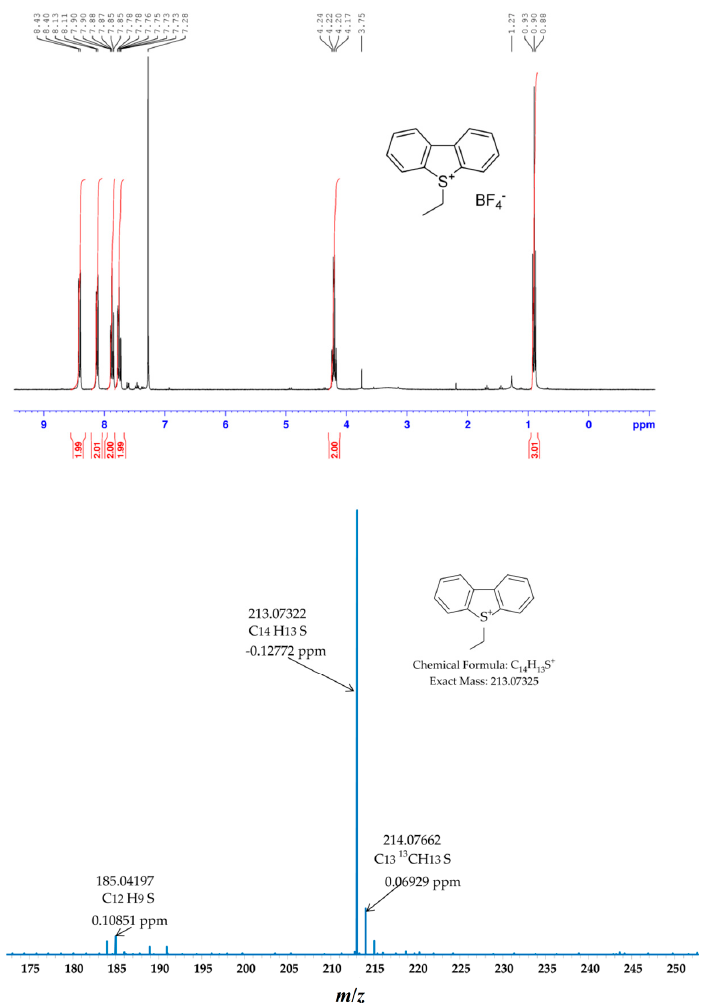
Figure 1. 1 H-NMR spectra ( top ) and HRMS (electrospray ionization Fourier transform ion cyclotron resonance mass spectrometry (ESI FT-ICR MS)) spectra ( bottom ) of 5-ethyldibenzo[ b , d ]thiophenium tetrafluoroborate.